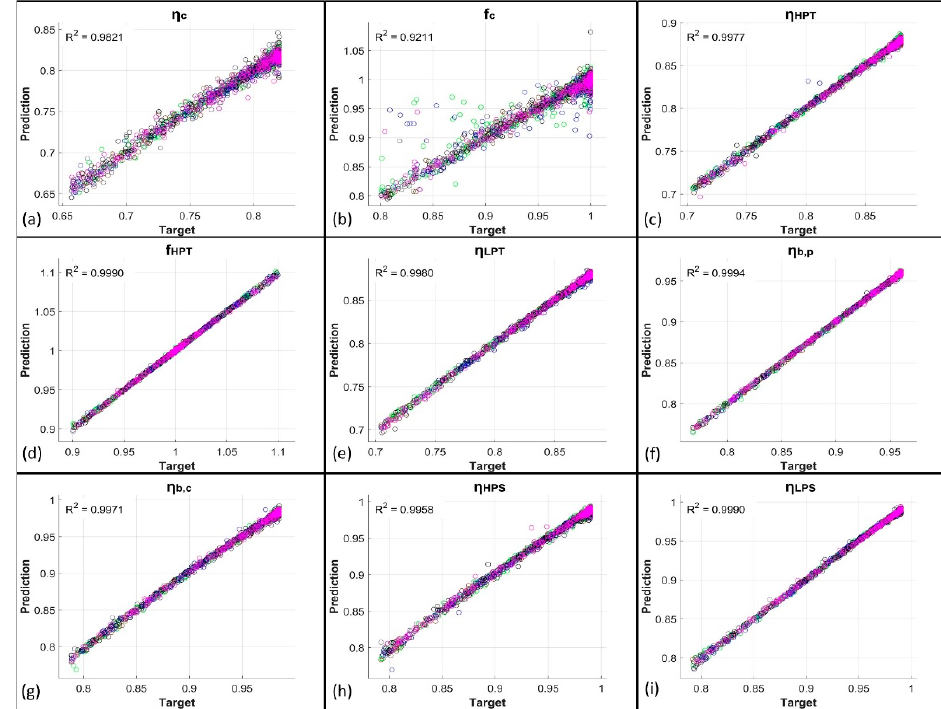
Figure 9. ( a – i ) Comparison between KPCA + FFNN predictions and targets about the PPs related to the multi-component degradation condition. Grey: START-A; brown: START-B; green: MAXPOW-A; blue: MAXPOW-B; black: MAXDUR-A; magenta: MAXDUR-B.